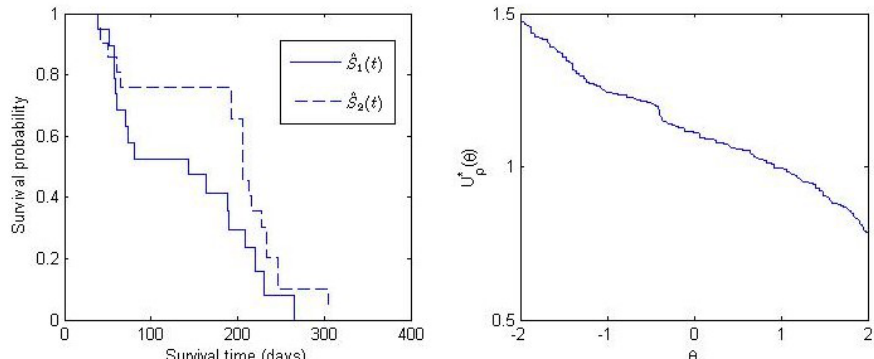
Figure 3. Estimated survival functions ( left ) and U ∗ ρ with ρ = 1 ( right ), vaginal cancer.